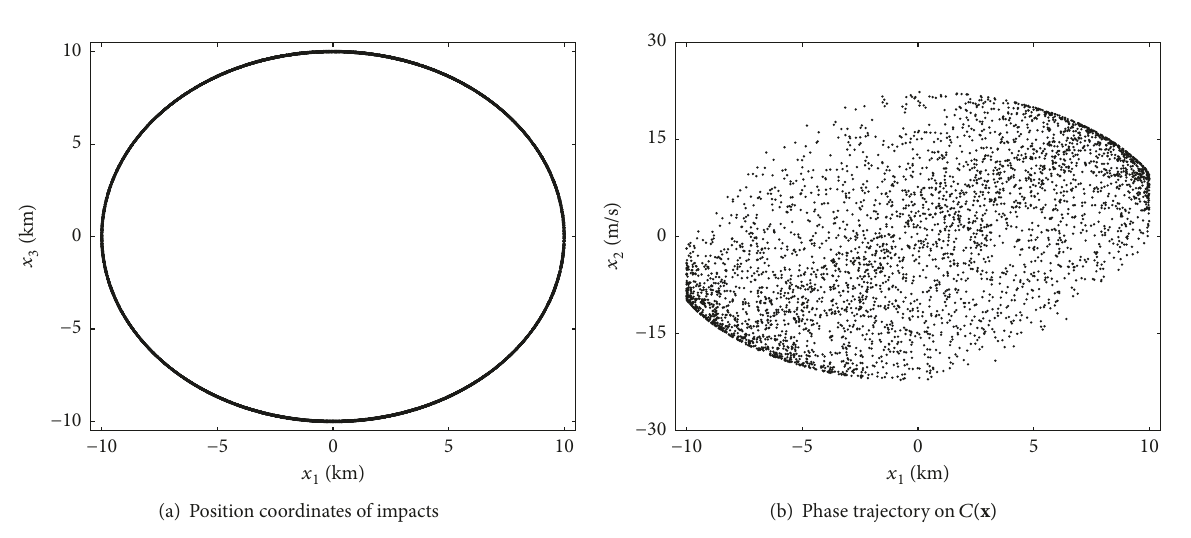
Figure 9: Quasi-periodic motion.